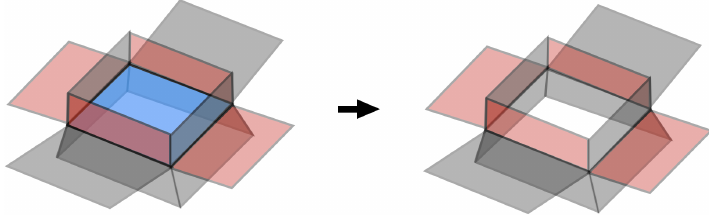
Figure 10 . Giving a non-zero VEV to a chiral field translates into deleting the corresponding face, which is colored blue here. This results in the two adjacent bricks recombining into a single